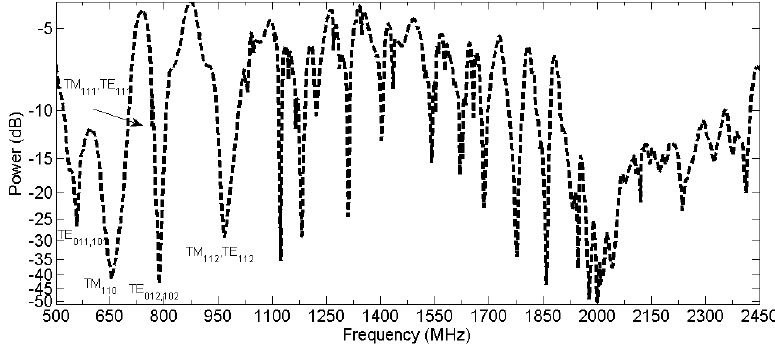
Figure 4. S 21 parameter (frequency response of the tank) measured with two 10 cm dipoles.